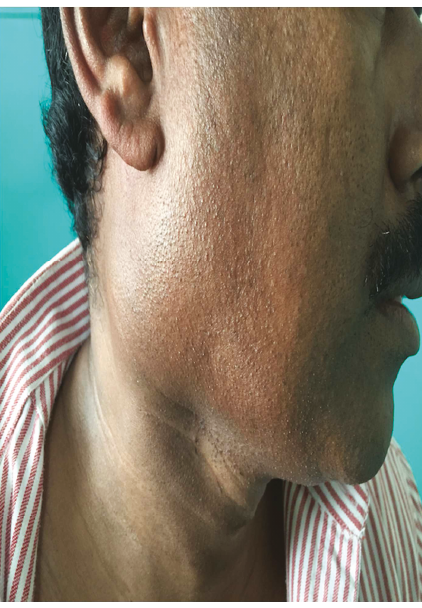
Figure 2: CECT neck shows cystic lesion medial to sternocleidomastoid muscle and inferomedial to parotid gland (arrows showing edge of the tumor). Eccentric solid area shows minimal enhancement on contrast